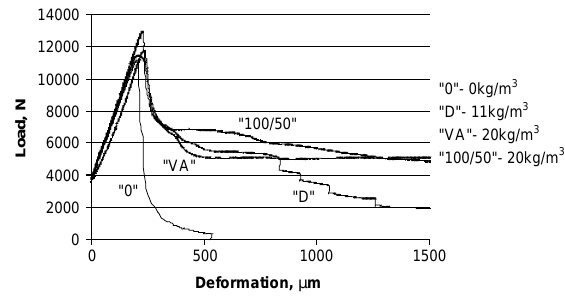
Fig. 10. The dependence of concrete reinforced by metal fibres deflection upon loading (Augonis et al . 2007)